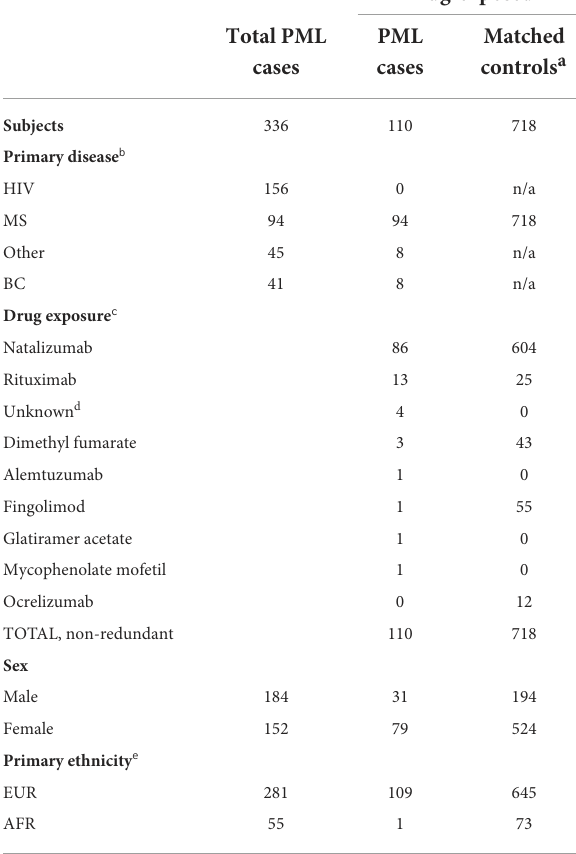
TABLE 1 Summary of PML cases and drug-exposed controls: primary disease group, MS drug exposure, and demographics.